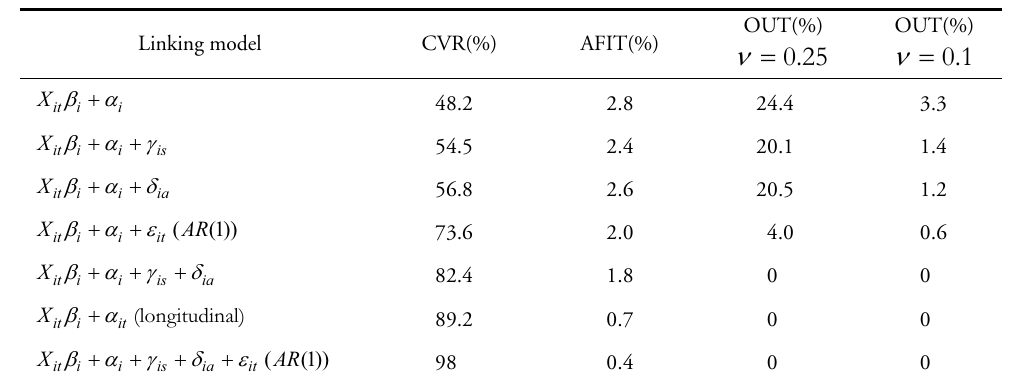
Performances of various “mixed linear” proposed models Linking